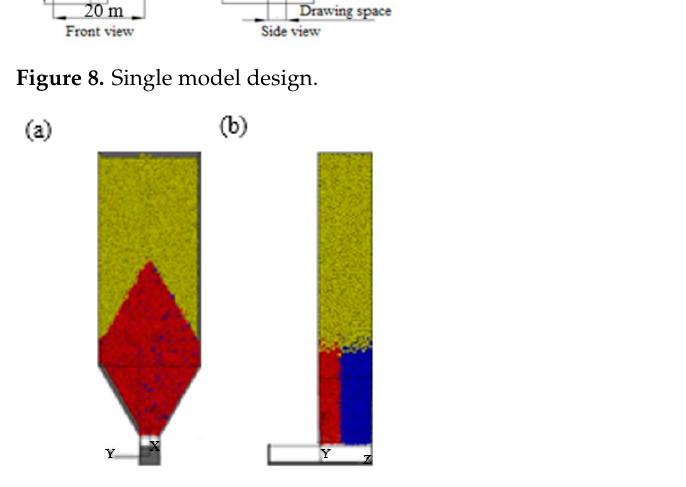
Figure 9. Initial diagram of the single model: ( a ) front view; ( b ) side view.